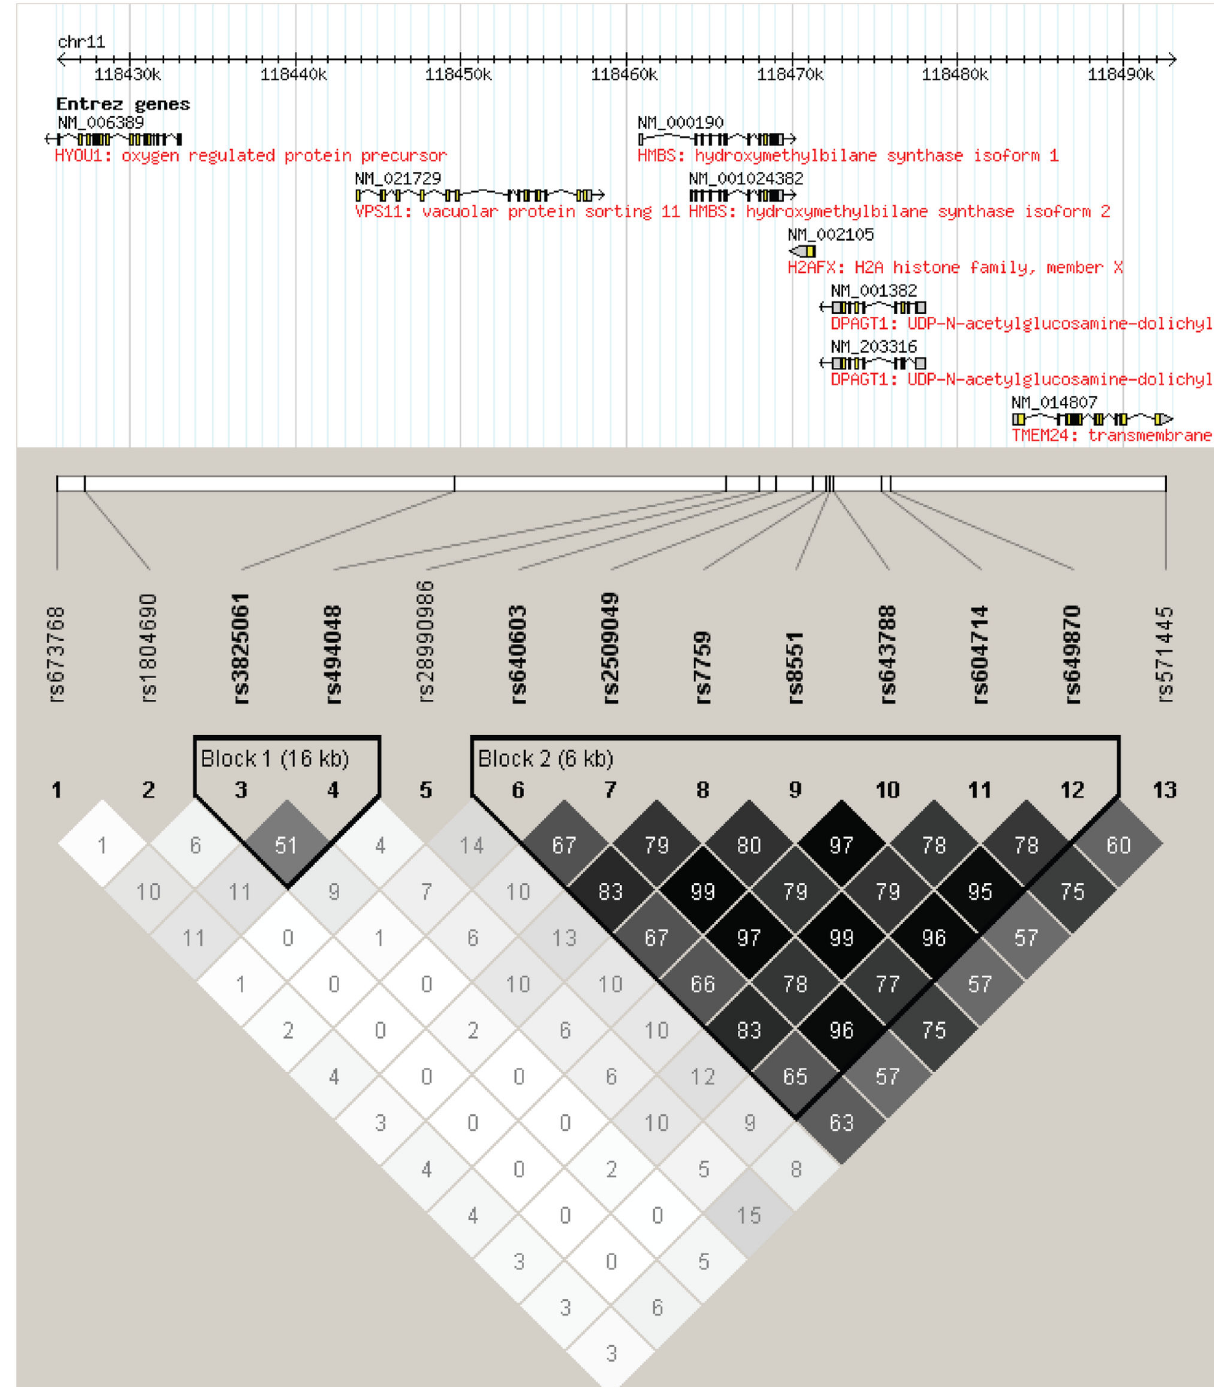
Figure 1. Linkage Disequilibrium for 13 SNPs in 1115 cases and controls in the BC population. Chromosomal coordinates (Hg18) and Entrez genes are mapped relative to the 13 SNPs analyzed in this study. The linkage disequilibrium plot shows r 2 values; predicted haplotype blocks are outlined in black. Figure created with Haploview version 4.2.